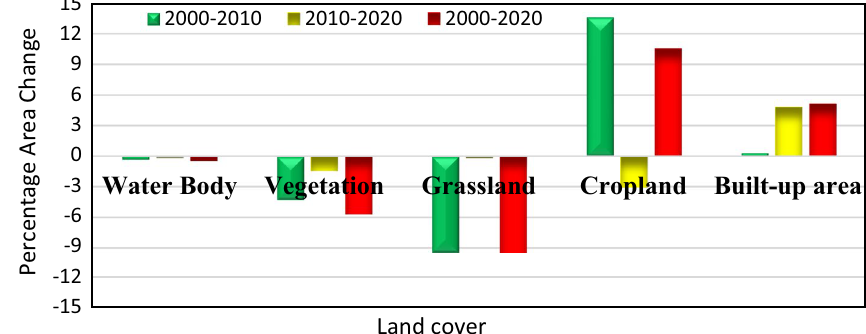
Fig. 10 The land use/cover